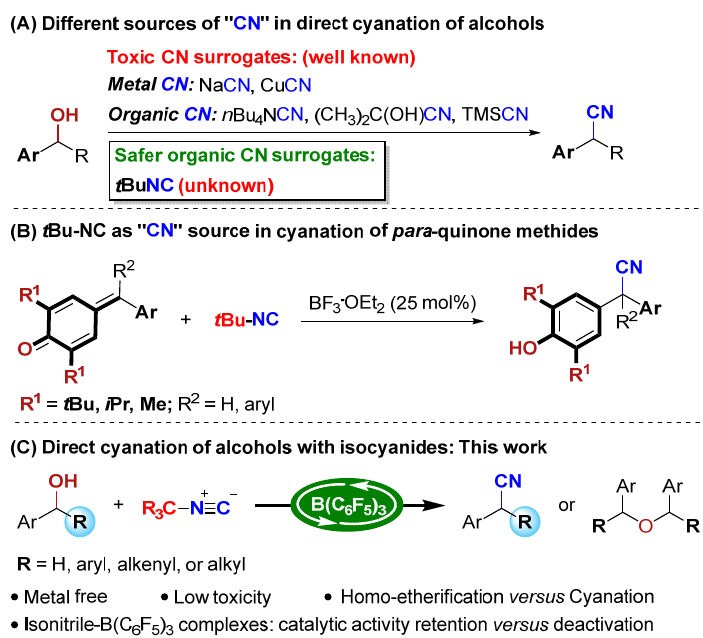
Figure 1. Verapamil, H-DAAN, and some derivatives of α -aryl nitriles.